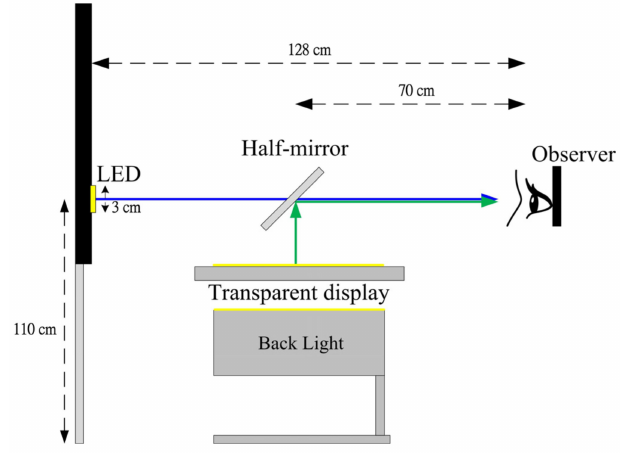
Figure 4. Illustration of the viewing